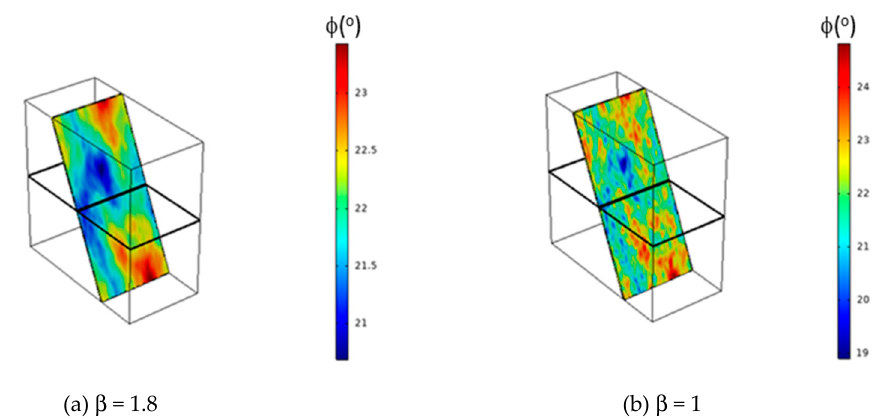
Figure 11. Artificial generation of friction angle for heterogeneous fault. The contours of generated values are in o .